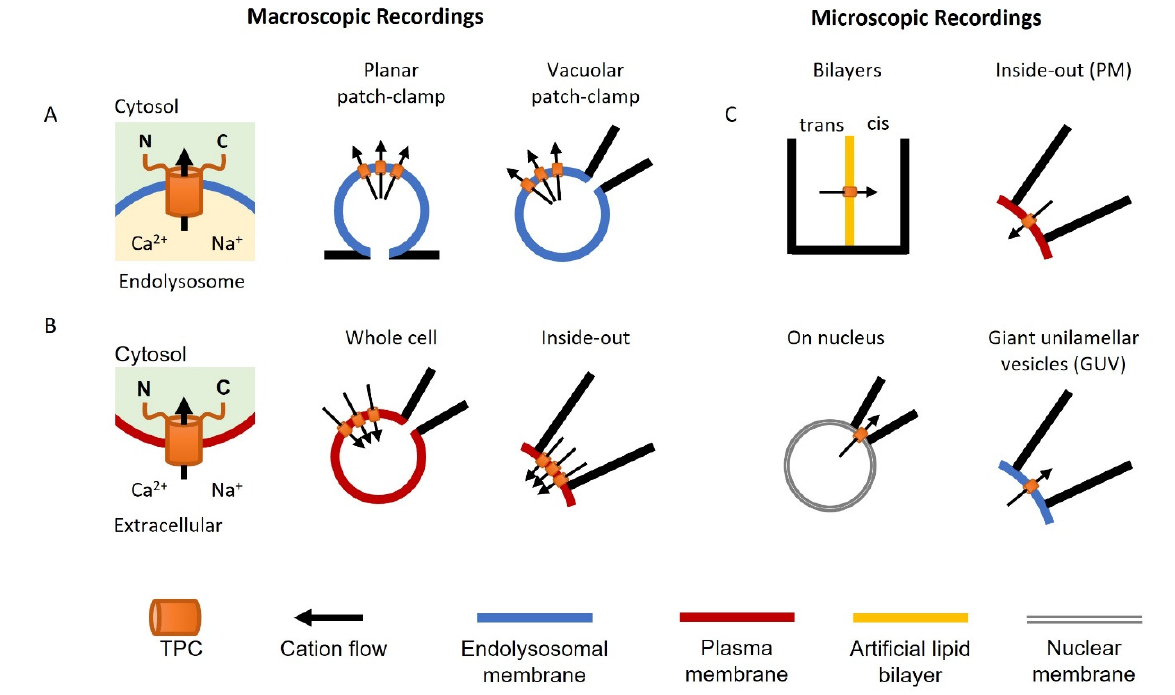
Figure 2. Electrophysiological methods used to characterize TPCs. Cartoon illustrations showing planar and vacuolar patch-clamp analyses of endolysosomal TPCs ( A ), conventional patch-clamp of plasma membrane TPCs in whole-cell and inside-out configurations ( B ), and single-channel analyses of TPCs imbedded in bilayers, isolated nuclei, the plasma membrane (PM), and giant unilamellar vesicles (GUV) ( C